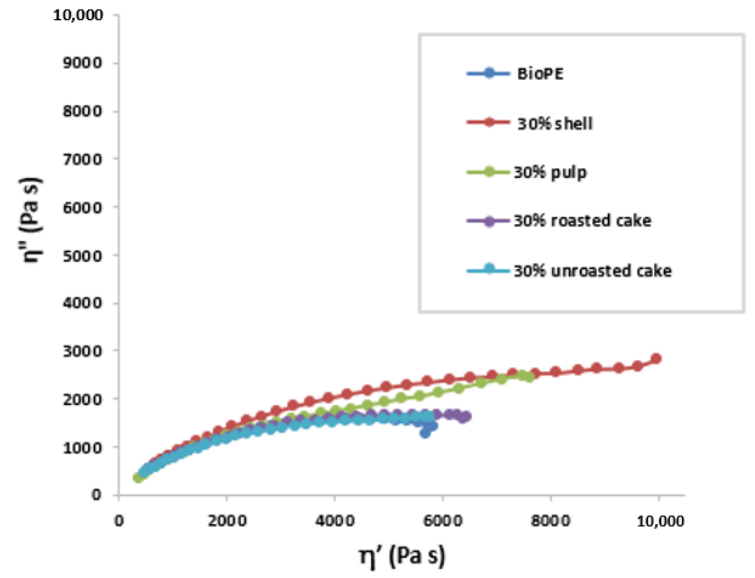
Figure 7. Cole – Cole plot for all the composites studied. Figure 7. Cole–Cole plot for all the composites